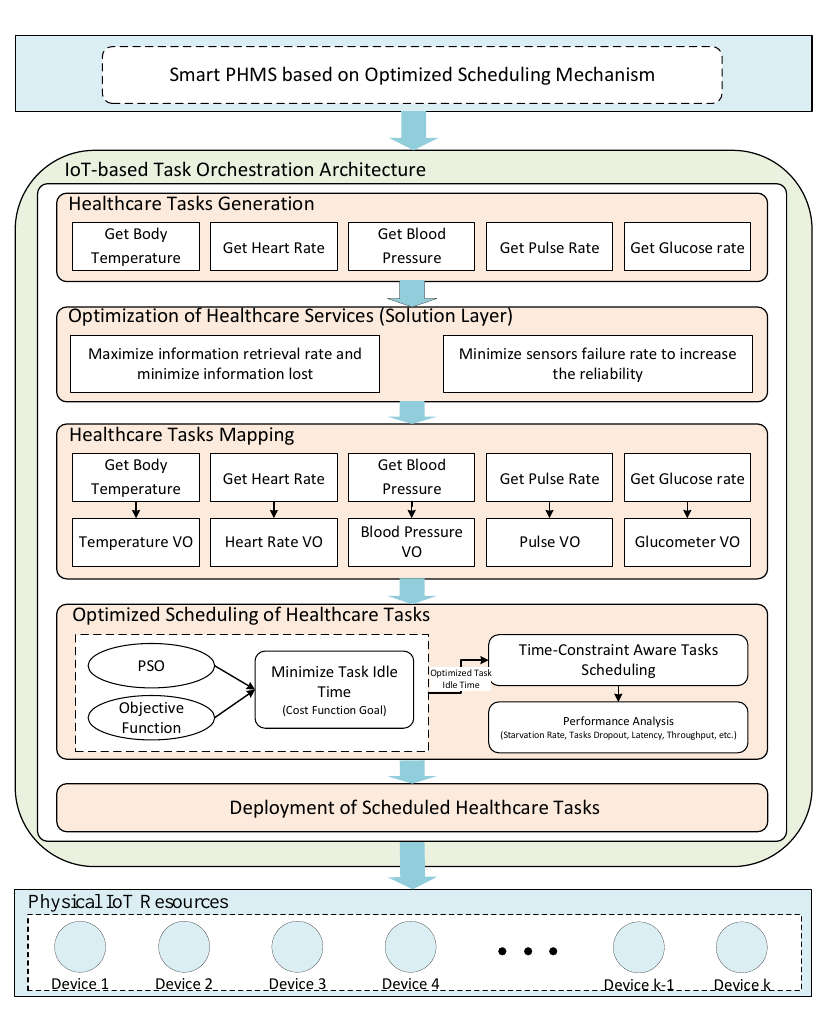
Figure 1. Proposed architecture of Smart patient health monitoring systems